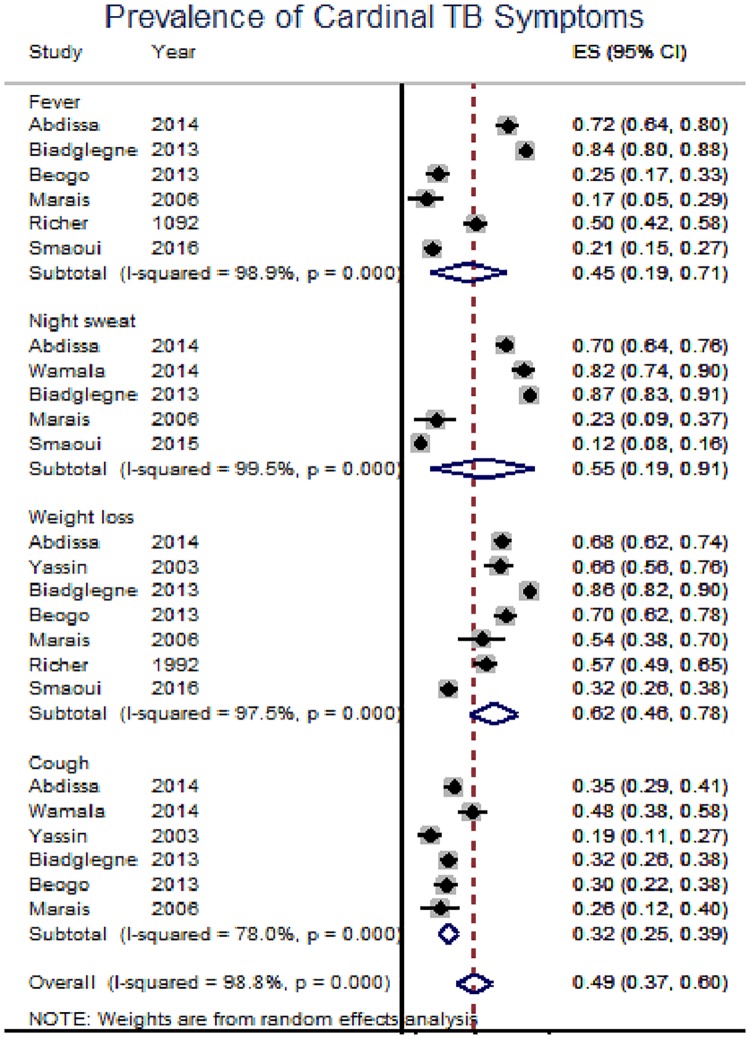
Prevalence of cardinal TB symptoms among TBLN cases, Africa, 1970–2015.